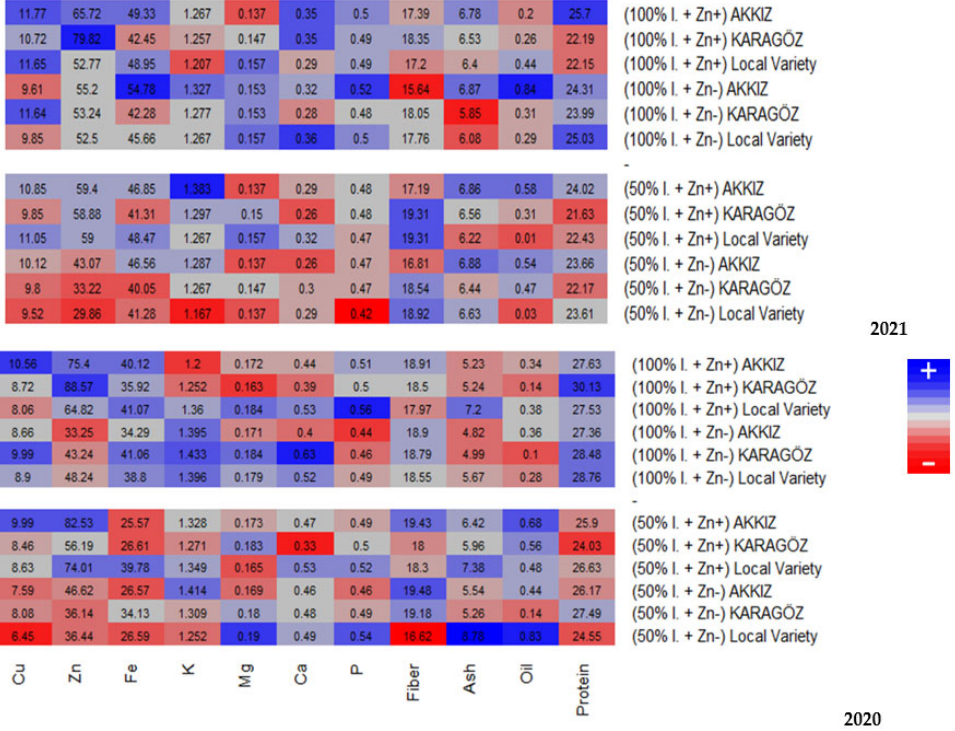
Figure 3. Mean values of grain quality components. Table 3. ANOVA of grain quality components (*: significant -: nonsignificant).